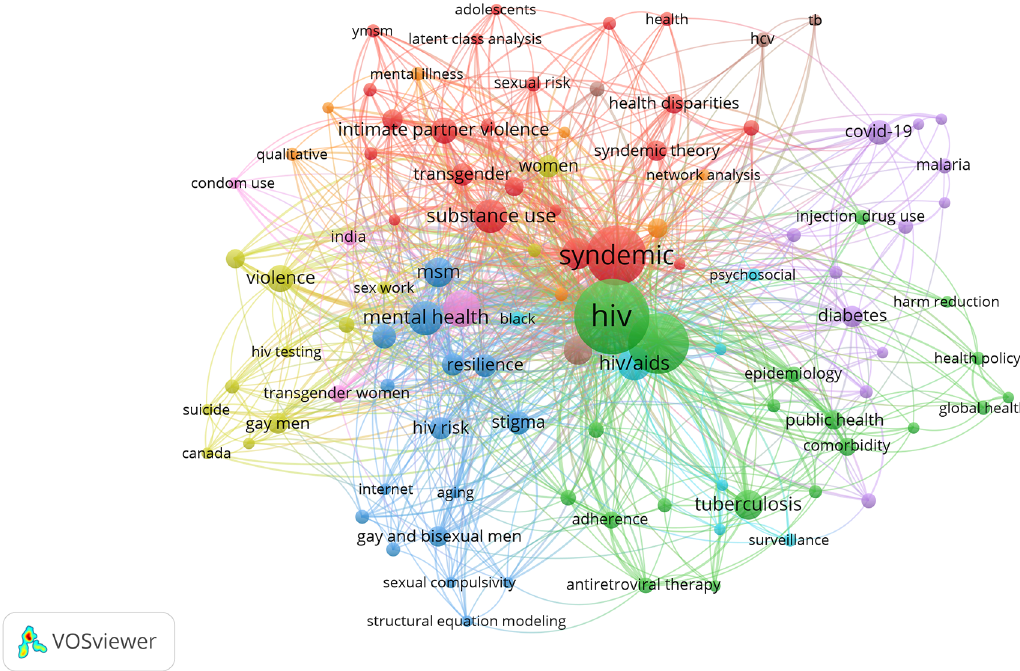
Figure 5. Research hotspots in syndemics